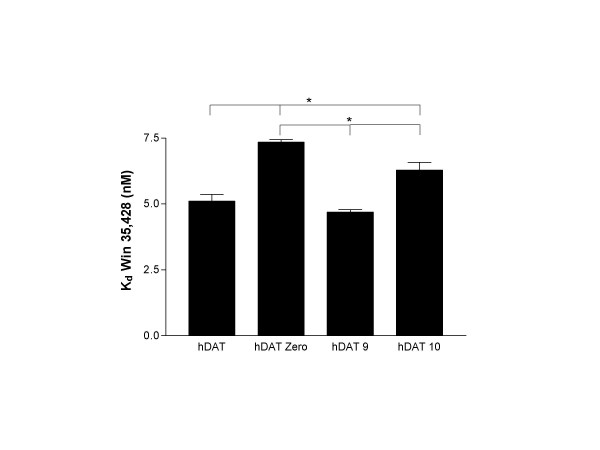
Mean Kd measurements derived from three independent [3H] Win 35,428 saturation binding assays. A one way ANOVA with Holm-Sidak post-hoc analysis detected VNTR-dependent differences in the DAT ligand affinity (* = p < 0.05) for all but the hDAT-vs-hDAT9 compairson.